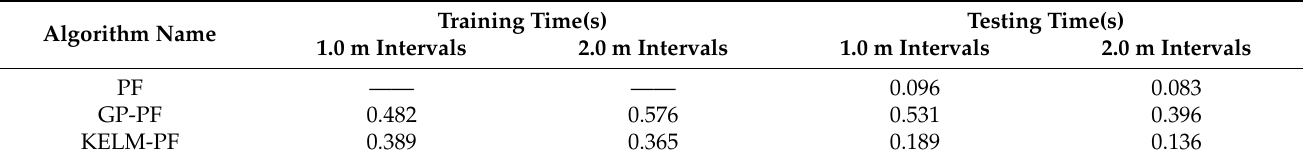
Figure 8. The RMSEs of PF, GP-PF and KELM-PF. Table 2. Comparison of running time of different